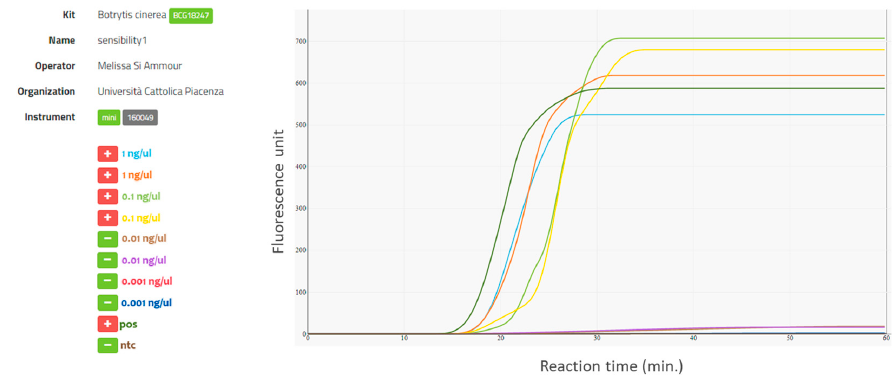
Figure 1. The real-time LAMP assay for Botrytis cinerea using 10-fold serially diluted DNA of B. cinerea (1.0 to 0.001 ng / µ L per sample). LAMP amplification curves generated in an ICGENE mini (Cat.No.EBT 801) portable instrument. Amplification curves and sample labels are colored correspondingly. + indicates amplification, and - indicates no amplification; pos is the positive control consisting of B. cinerea DNA as template, and ntc is the control consisting of water as